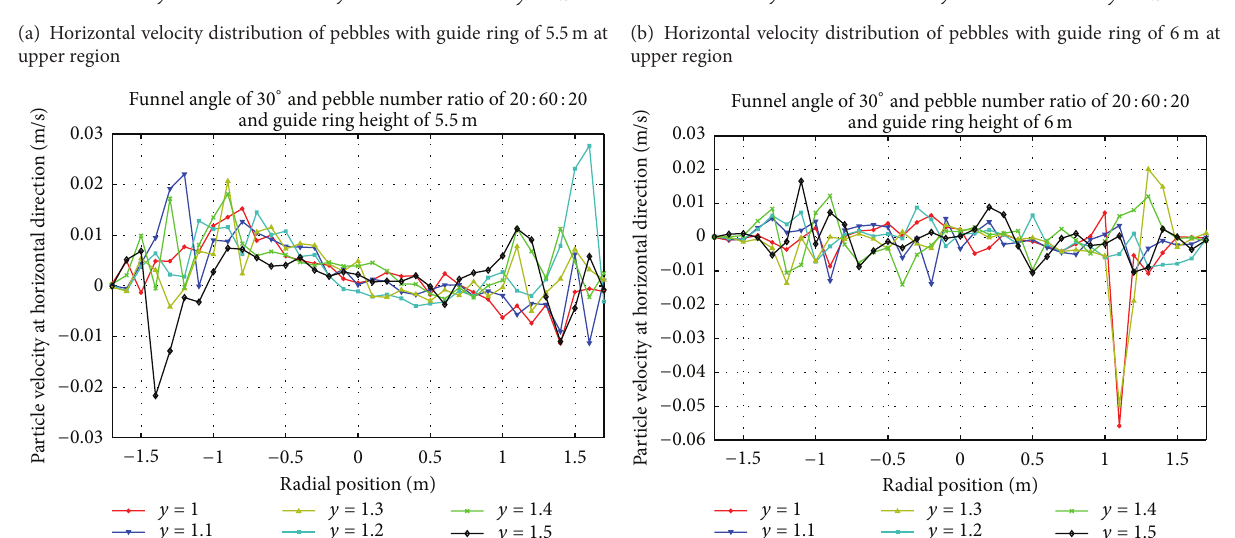
(c) Horizontal velocity distribution of pebbles with guide ring of 5.5m at lower region mFunnel angle of 30 ∘ and pebble number ratio of 20 : 60 : 20 and guide ring height of 5.5